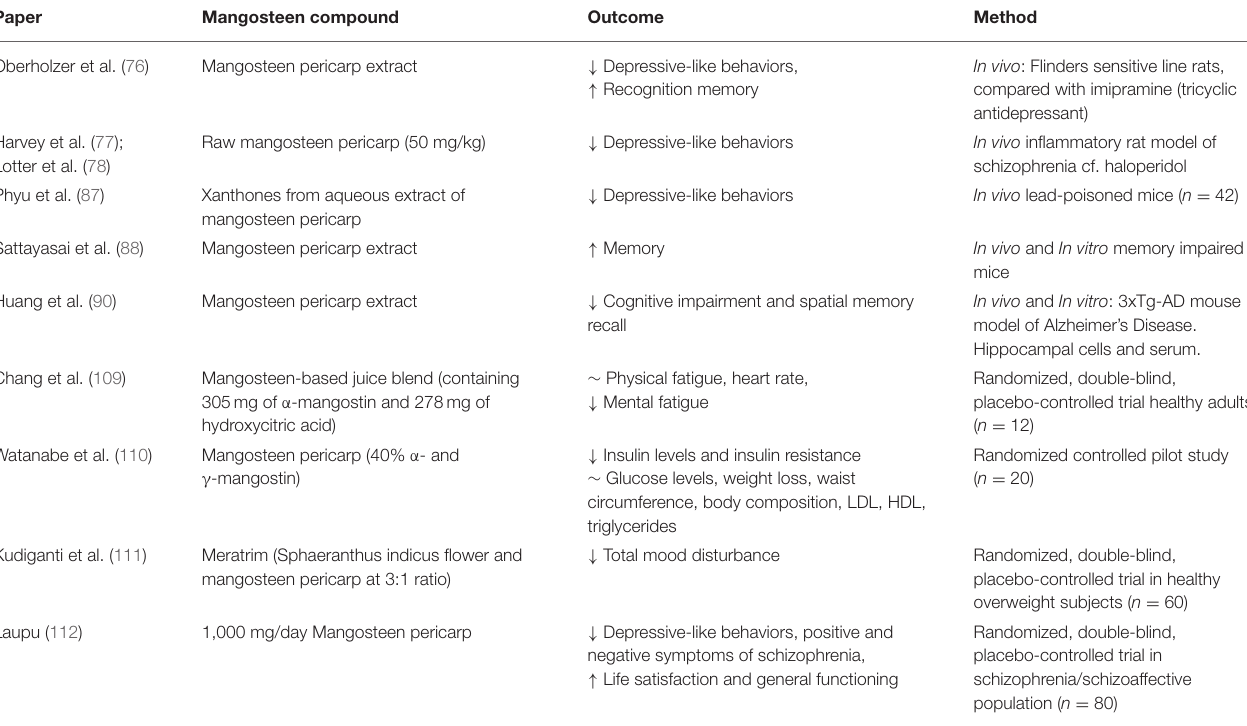
TABLE 2 | Summary of behavioral evidence for Garcinia mangostana Linn . (mangosteen).